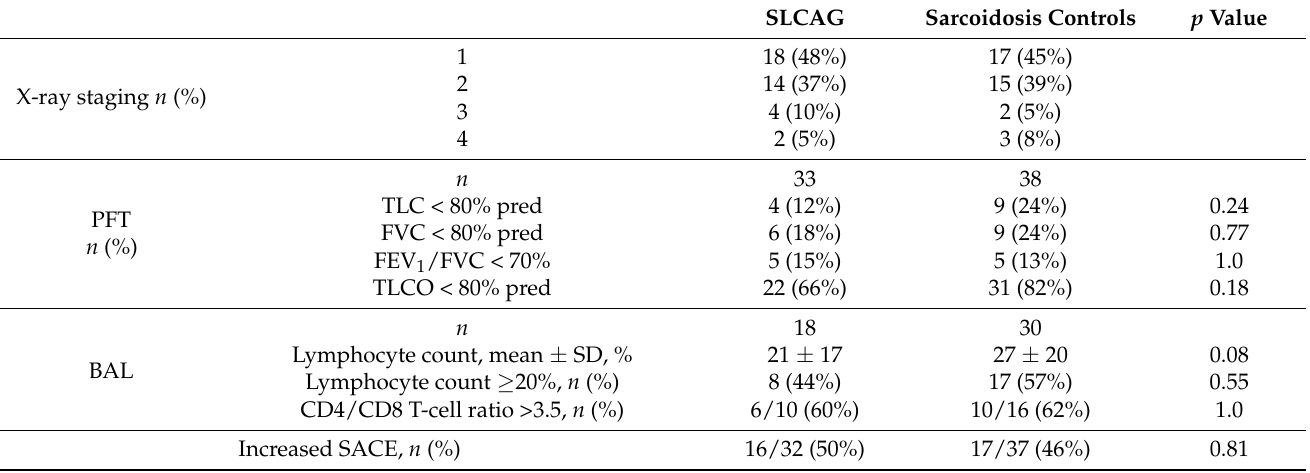
Table 3. Radiological, functional, and biological characteristics of SLCAG and sarcoidosis patients. SLCAG Sarcoidosis Controls p Value